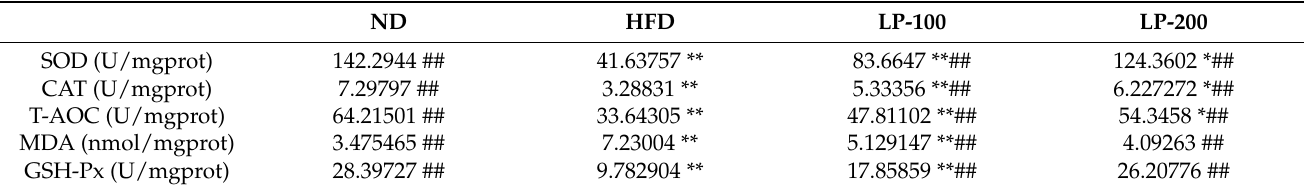
Table 4. LPs effect on renal MDA, SOD, GSH-Px, T-AOC, and CAT levels in HFD-fed rats. ND HFD